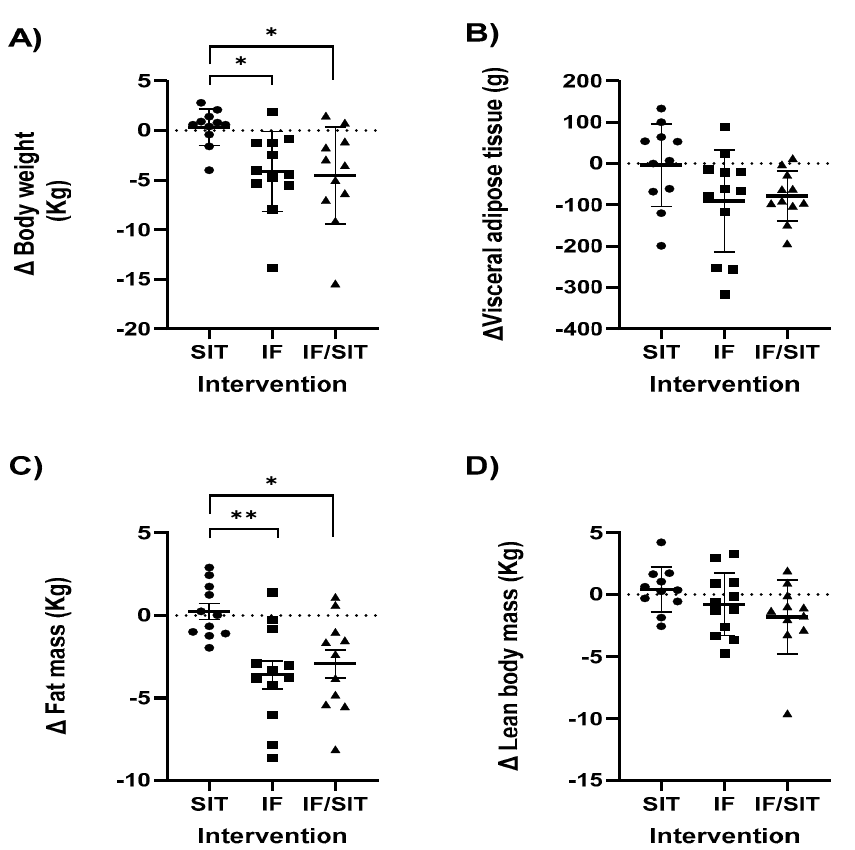
Figure 2. Individual and group (mean ± SD) changes from baseline to post intervention in ( A ) body weight; ( B ) visceral adipose tissue; ( C ) fat mass and ( D ) lean body mass for each diet and/or exercise intervention. * and ** denotes a significant difference between groups ( p < 0.05 and p < 0.01, respec- tively). Abbreviations: SIT: sprint interval training, IF: intermittent fasting and IF/SIT: intermittent fasting and sprint interval training.